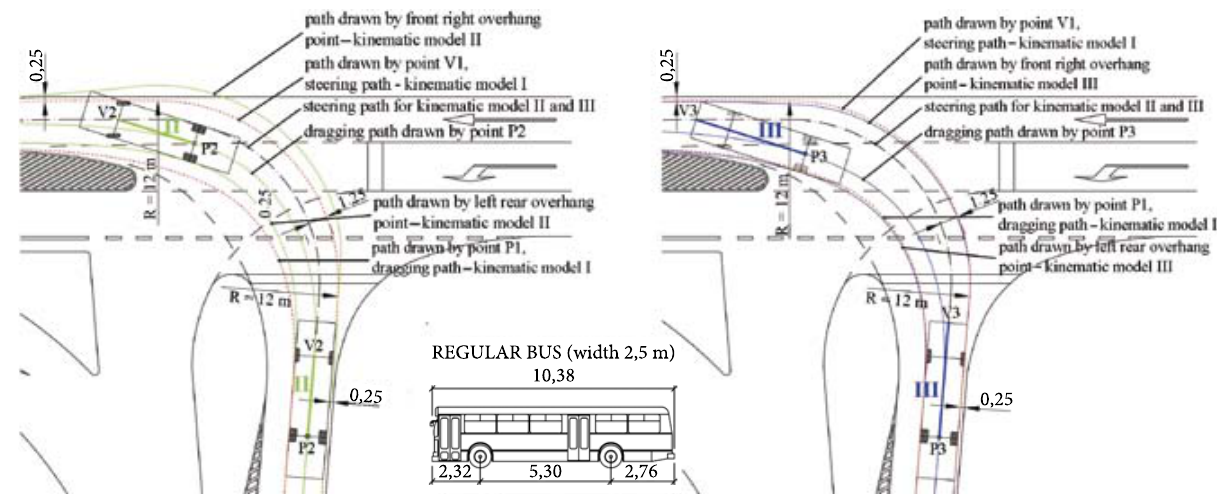
fig. 5. Setting vehicle movement trajectory – kinematic model II and